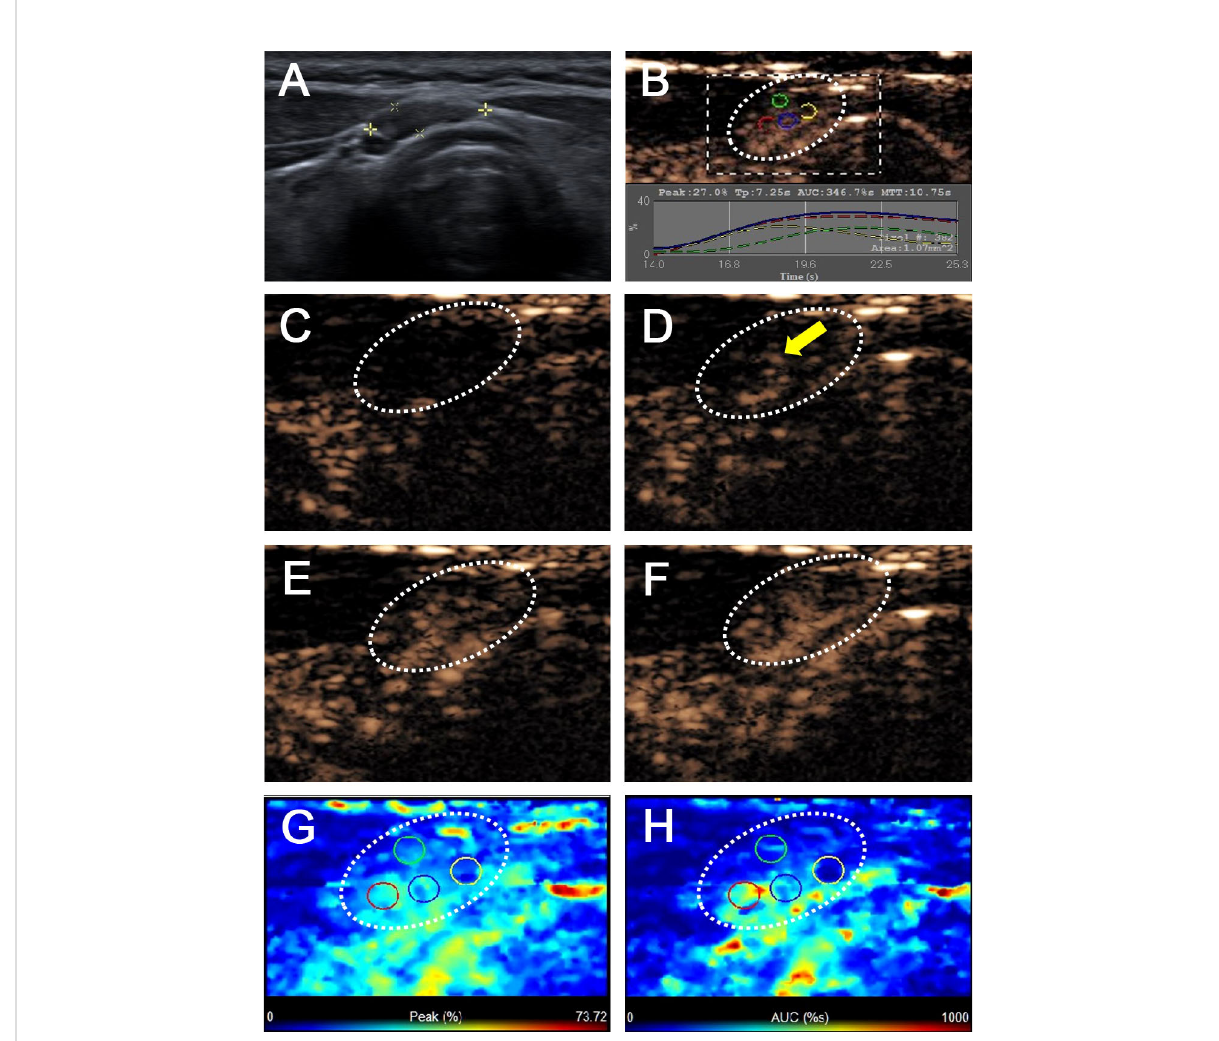
FIGURE 3 Benign lymph node in a 43-year-old female patient with PTC with Hashimoto ’ s thyroiditis. (A) A pretracheal CCLN with the absence of fatty hilum (white cross) identi fi ed on conventional US. (B) Time-intensity curve of CCLN. (C – F) CEUS images at different times, (C) before injection of contrast agent, the CCLN showed no microbubbles signal; (D) at 10 s, the CCLN showed the microbubbles signal from the center of the lymph node (yellow arrow); (E) at 14 s, the whole CCLN showed homogeneous enhancement, which is equal to the surrounding thyroid tissue; (F) at 16 s, the whole CCLN showed homogeneous iso-enhancement, which is equal to the surrounding thyroid tissue. (G, H) Parametric color maps of PI and AUC values, PI and AUC values of the whole lymph nodes (cyan and blue colors) was equal to the surrounding tissue (cyan and blue colors), means PI index ≤ 1 and AUC index ≤ 1, (G) PI values for the center of CCLN were higher than those of the periphery of CCLN, which were homogeneous of the whole CCLN; (H) AUC values for the center of CCLN were higher than those of the periphery of CCLN, which were also homogeneous of the whole